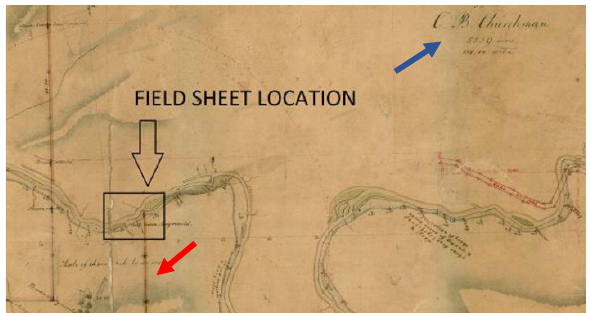
Figure 4: Historical map including property boundaries. The most common way of changing property boundaries in Perth is through subdivisions. Therefore, the property boundaries (next to many new property boundaries) should still exist today. The attempt was made to identify the property corners, and to use those to geo-reference the historical maps. The coordinates of the property corners in Figure 5 are provided in the MGA94 coordinate system. However, careful investigation has shown that the corner points highlighted in red in Figure 5 are incorrect, and that, therefore, not always did a simple subdivision take place. Therefore, this method has been discharged.